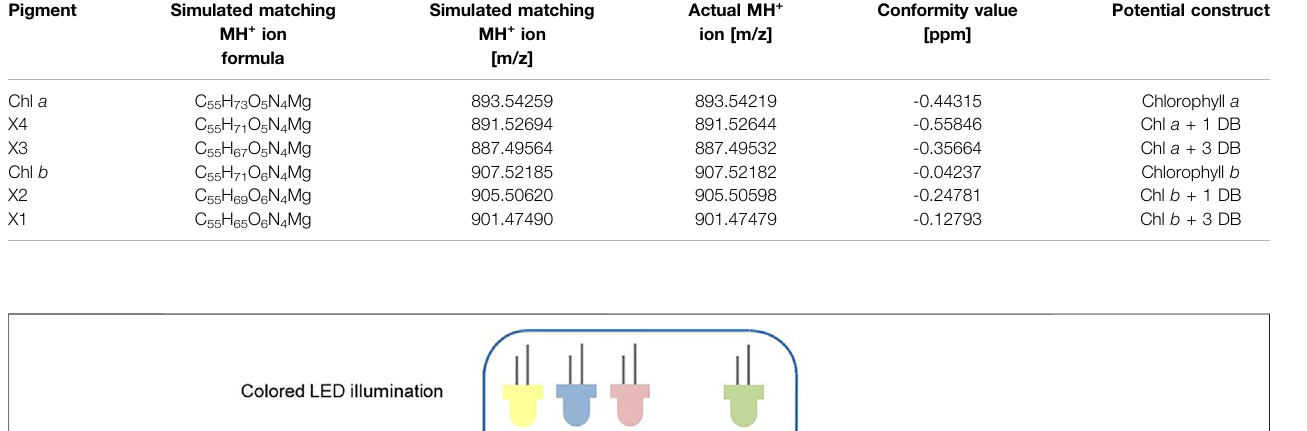
Frontiers in Bioengineering and Biotechnology |